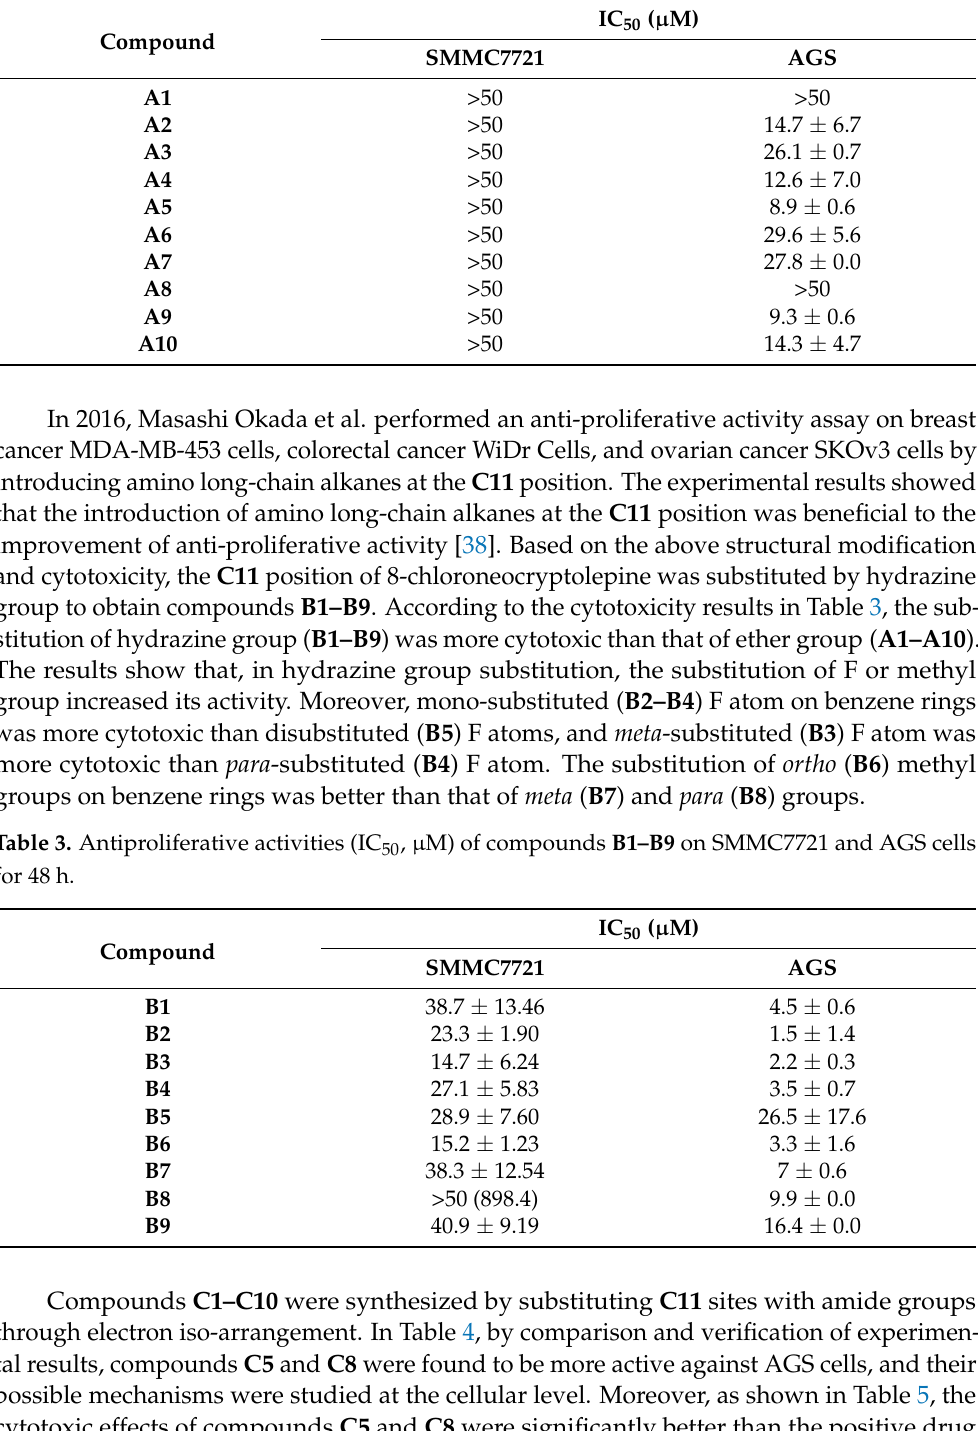
Table 2. Antiproliferative activities (IC 50 , µ M) of compounds A1–A10 on SMMC7721 and AGS cells for 48 h.